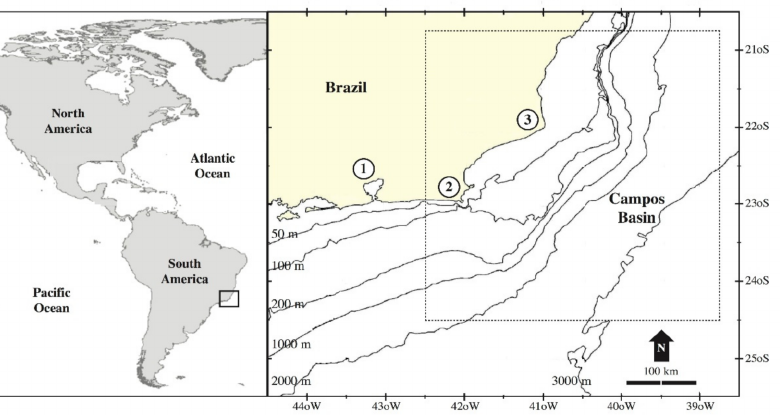
Figure 1. Area of interest offshore from the southeastern Brazilian coast: Campos Basin. The dashed square shows the region of the observed features: oil spills and look-alike slicks. Guanabara Bay ( 1 ), Cabo Frio ( 2 ), Cabo de S ã o Tom é ( 3 ), and isobaths (50 m, 100 m, 200 m, 1000 m, 2000 m, and 3000 m) are shown. See also Section